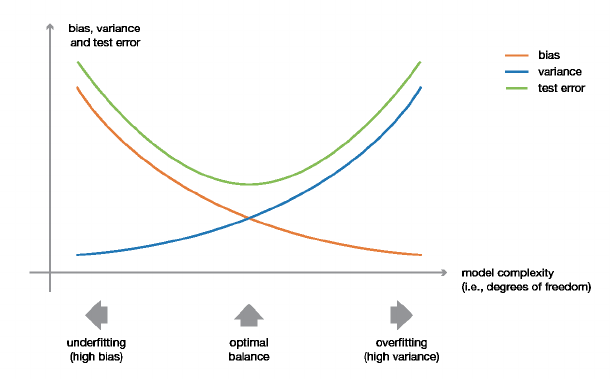
Figure 1. Illustration of the bias-variance